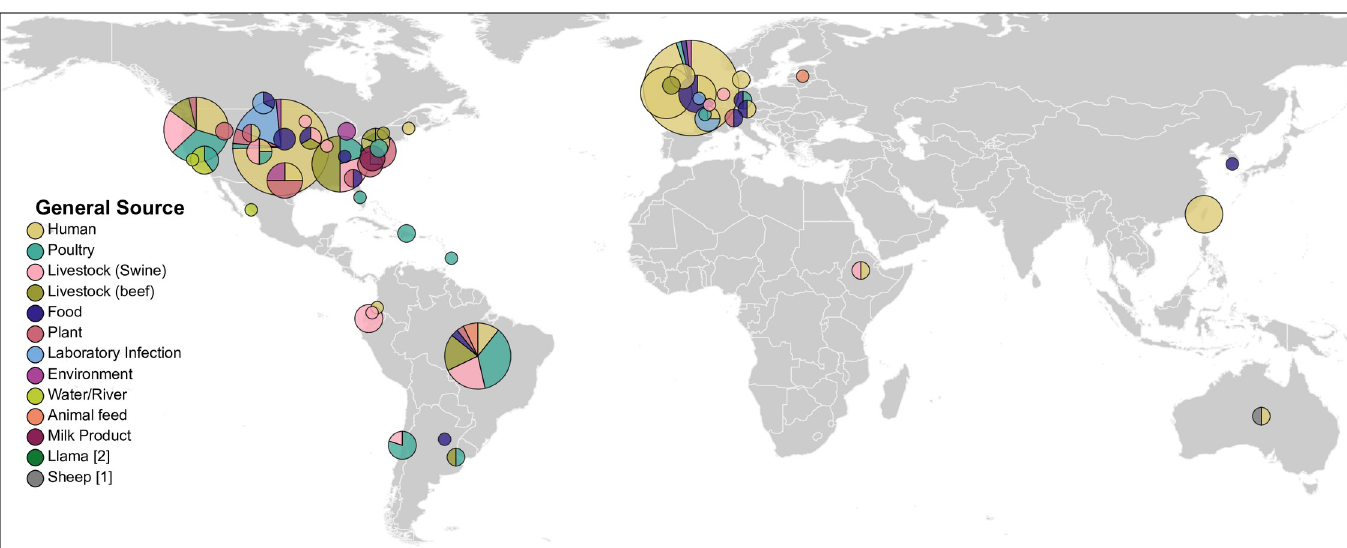
Fig 3. Pie charts of the environmental sources of 341 natural Salmonella strains in HC20_373 according to geographic source. The diameters of the pie charts are scaled to the numbers of isolates from each geographical source. Seventeen of the isolates were from laboratory infections and the others were from the sources indicated in the Key Legend (left). Map and pie charts were generated using the open-source D3.js [65] library GeographicLib [66] with the MIT/X11 license at https://github.com/ d3/d3-geo/blob/main/LICENSE.